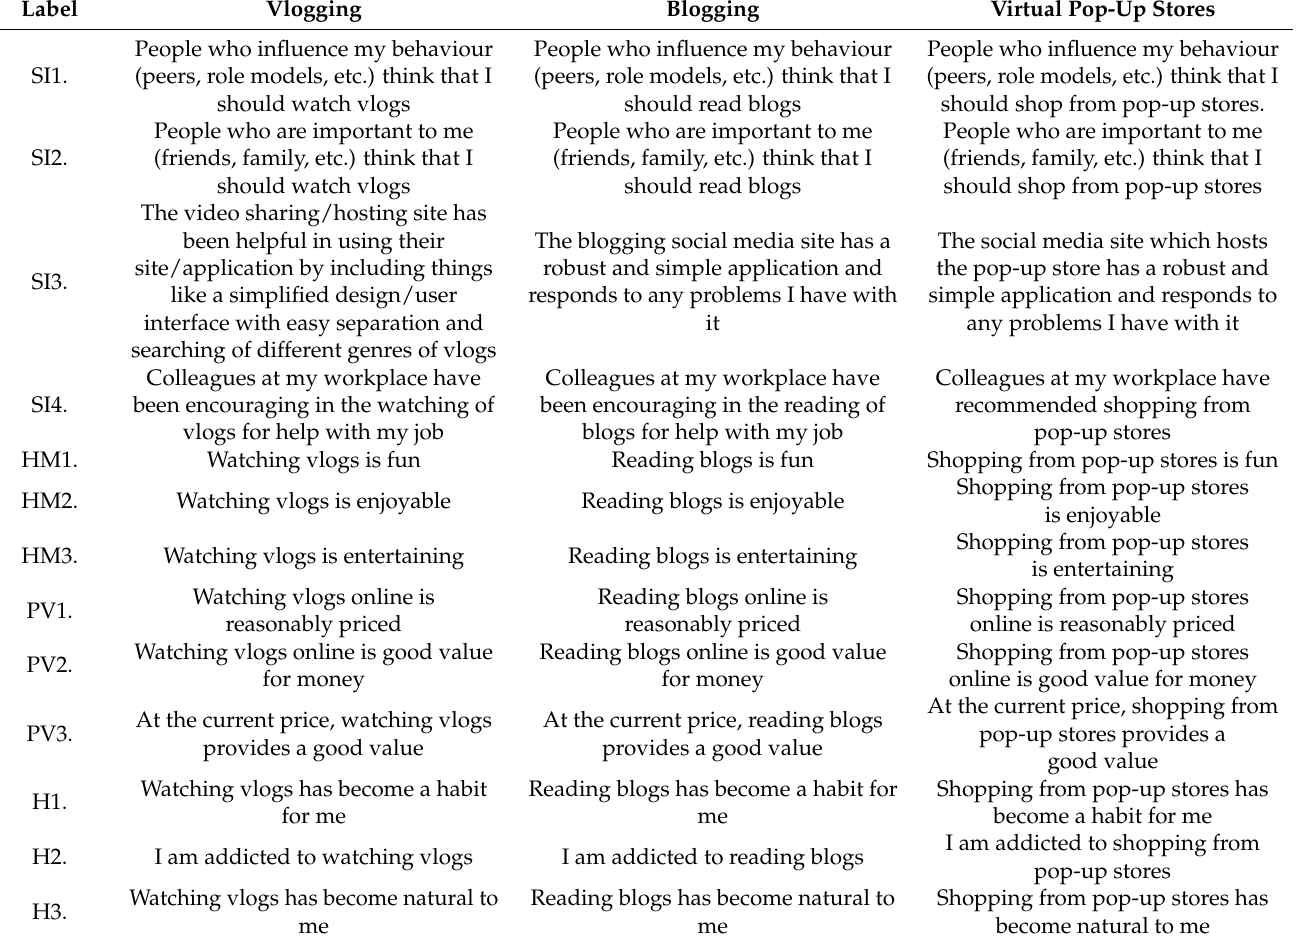
Table A1. Survey questionnaire